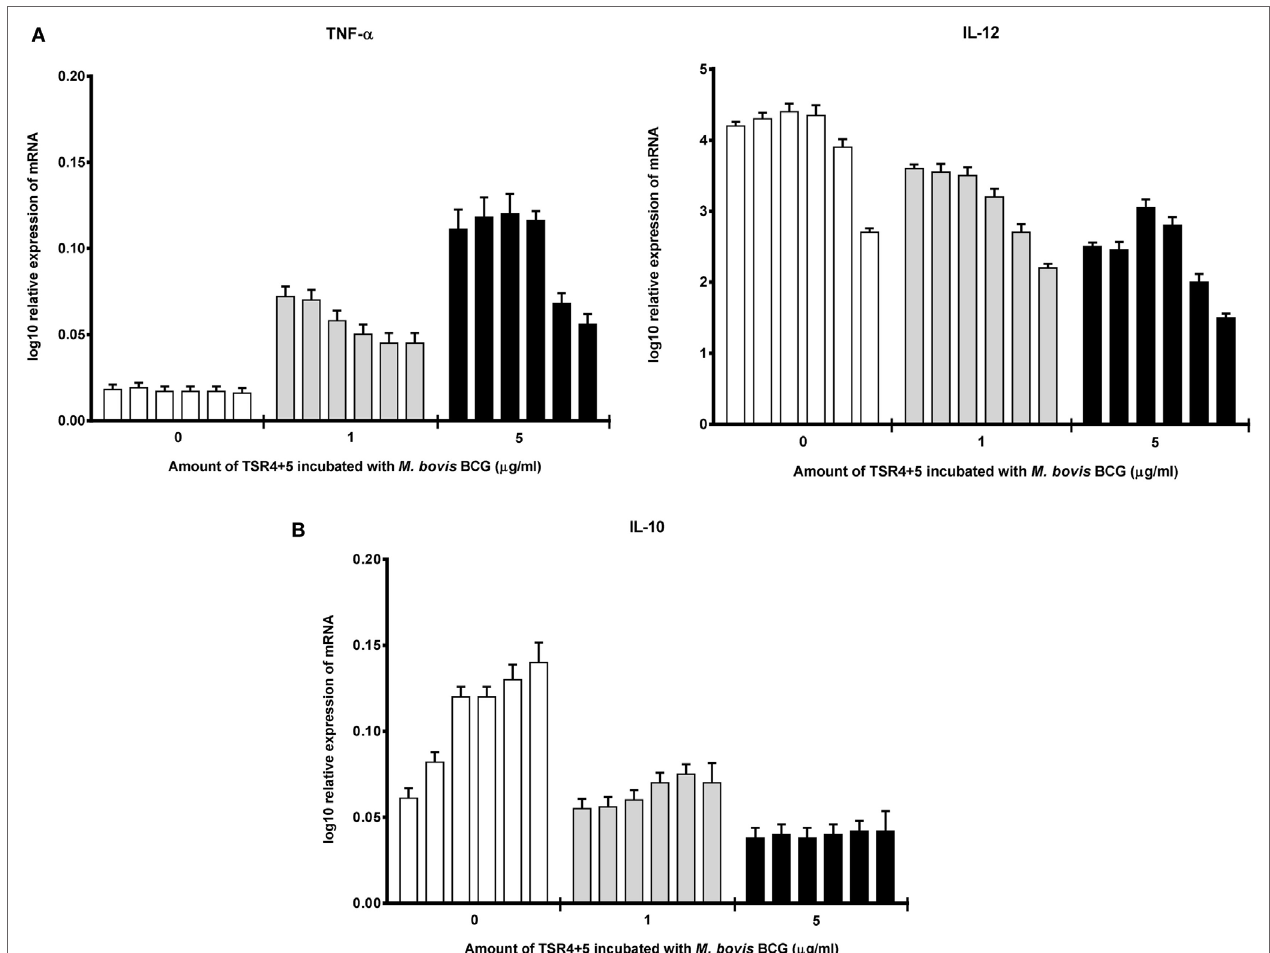
FigUre 5 | Temporal mRNA expression profile of cytokines produced by THP-1 cells incubated with different concentrations of thrombospondin repeats (TSR) 4 + 5 and Mycobacterium bovis BCG. (a) Pro-inflammatory cytokines: TNF- α and IL-12; (B) anti-inflammatory cytokine: IL-10. The expression of each cytokine was measured using qPCR, and the relative expression [relative quantification (RQ)] calculated by normalizing the data using human 18S rRNA expression as a control. The RQ value was calculated using the formula: RQ = 2 −ΔΔ Ct . Assays were conducted twice in triplicates. Error bars represent SD. A two-way ANOVA test was performed on the data to determine significant differences in expression of cytokine production by TSR4 + 5. All comparisons were significant ( p < 0.05), unless where shown (ns, not significant, p >